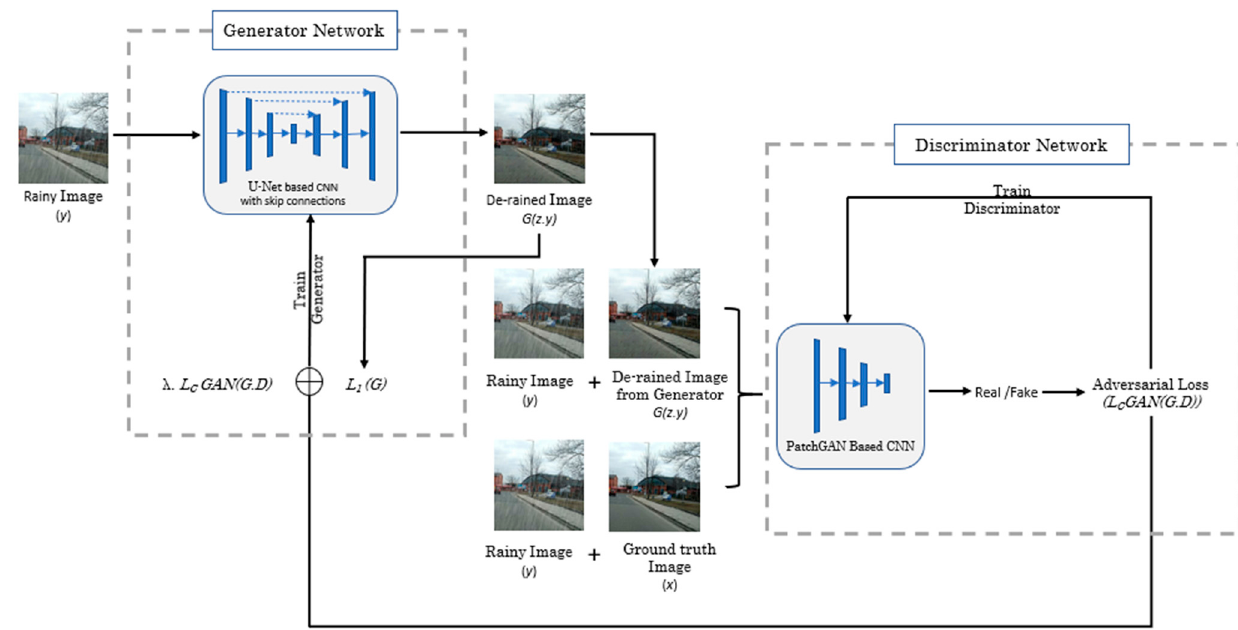
Figure 1. High-level architecture of the proposed model